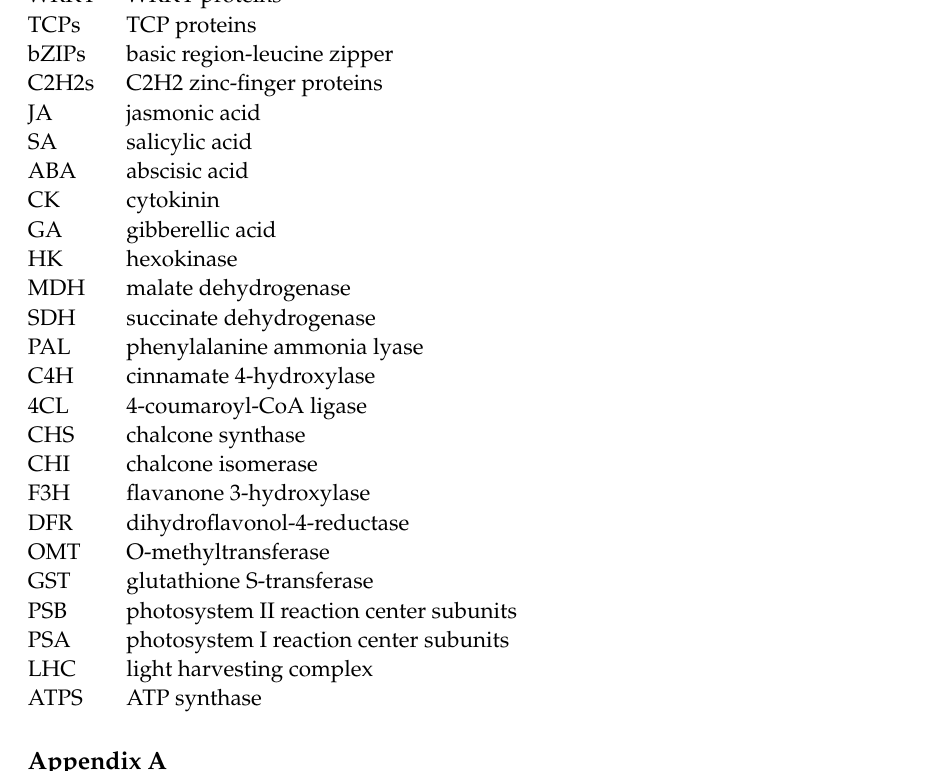
Figure A1. Full ‐ length transcriptome and differential genes overview of HQ and YS10. ( A ): The number of transcriptomes in the two strains. ( B ): The number of differentially expressed genes be ‐ tween each group in the pairwise comparison. ( C ): KEGG pathway analysis of DEGs.